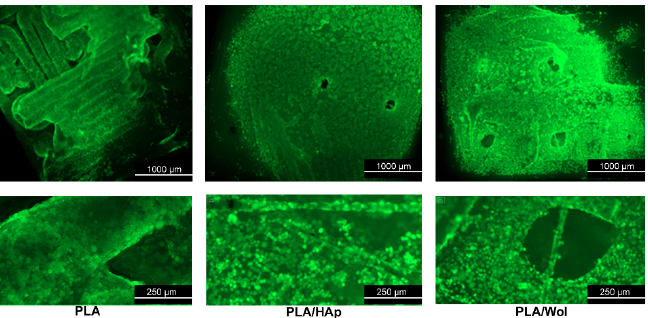
Figure 8. MSCs colonization of PLA-based sample surfaces: ( A ) ×2.5 magnification; ( B ) ×4 magni- Figure 8. MSCscolonizationofPLA-basedsamplesurfaces: ( A ) × 2.5magnification; ( B ) × 4 fication.